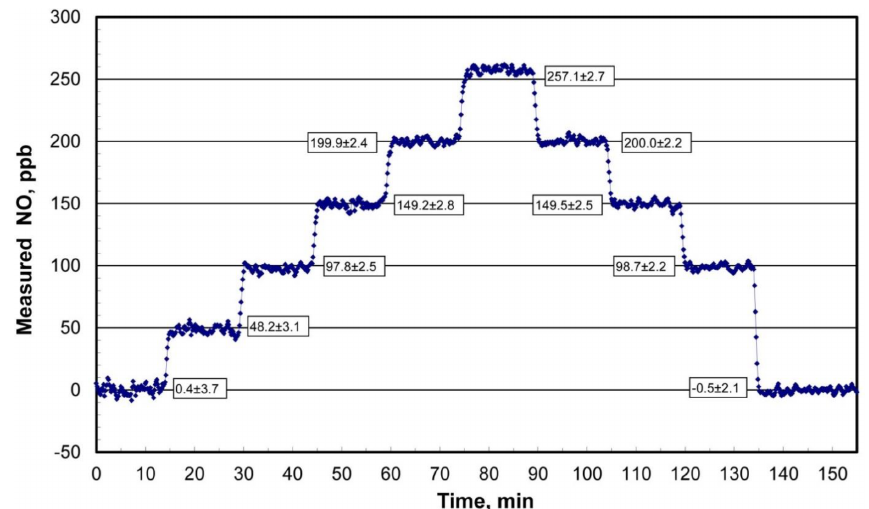
Figure 4. Measured output from the Model 408 NO Calibration Source for programmed NO mixing ratios of 0, 50, 100, 150, 200, 250, 200, 150, 100, and 0ppb and time steps of 15min. Average concentrations after the 1min step changes are shown along with standard deviations.